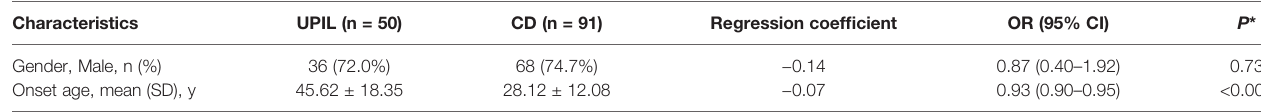
TABLE 1 | Demographic Characteristics of participants with Crohn ’ s disease or Ulcerative Primary Intestinal Lymphoma.